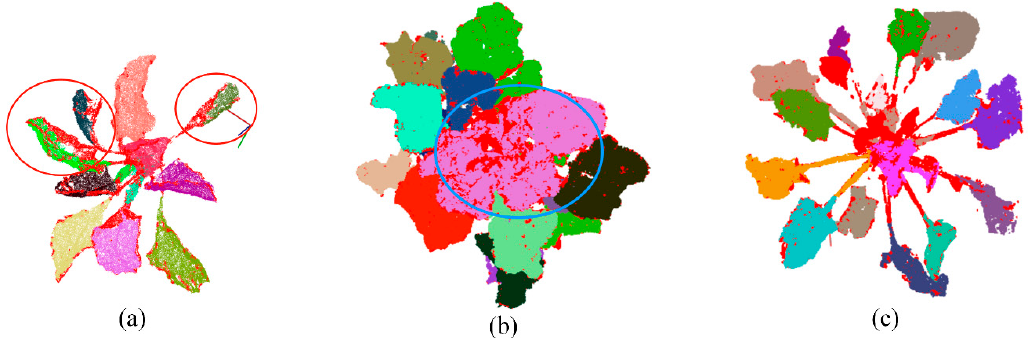
Figure 7. Point cloud segmentation of sugar beet into individual leaves at ( a ) T1, ( b ) T2 and ( c ) T3 growth stages using regional-growing algorithm. Different colors represent individual leaves at different position on the plant. The red points on each leaf were discarded points at the first segmentation. Leaves in red circle were the curved leaves which lost many points after segmentation. Leaves in blue circle were overlapped with each other at stage T2 and cannot be segmented properly into individual leaves.